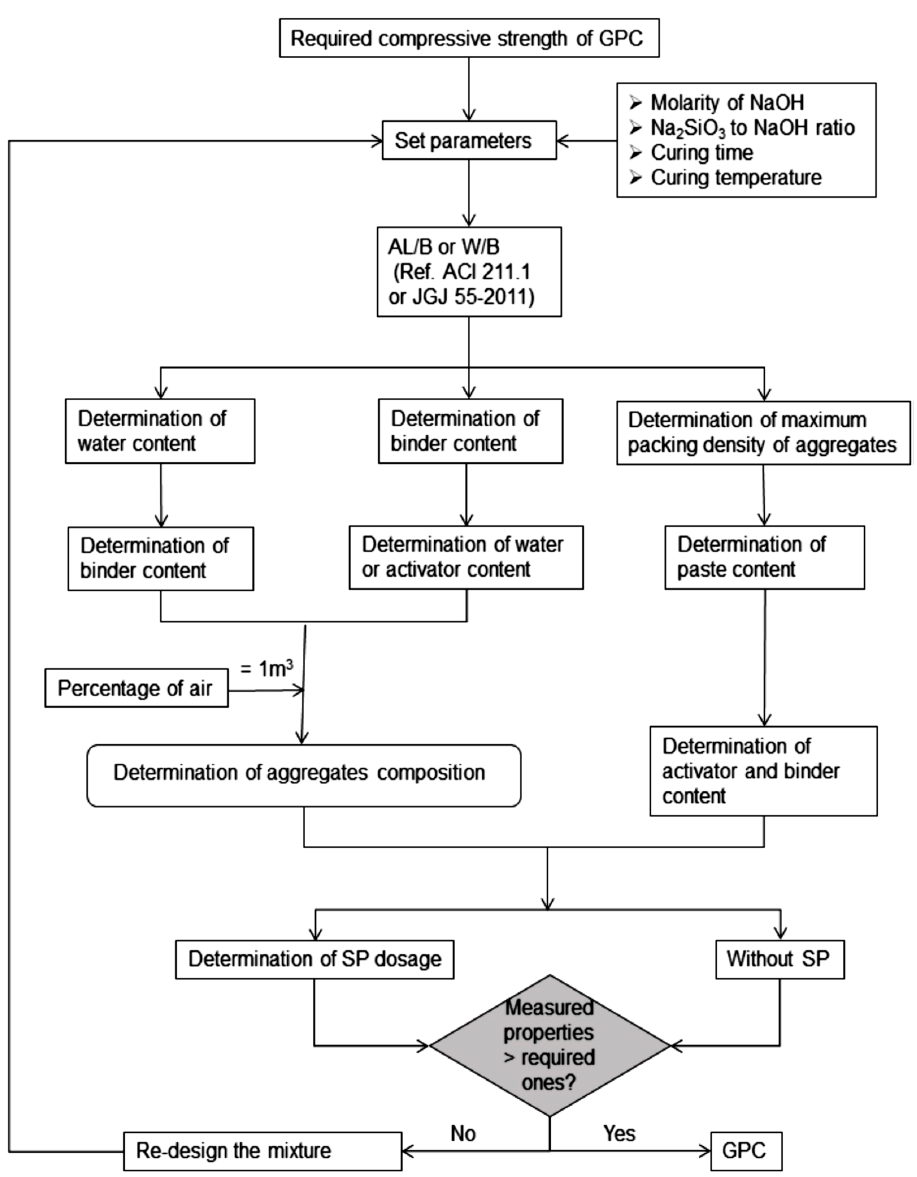
Figure 14. Mixture design method for GP concrete. Adapted from [141].